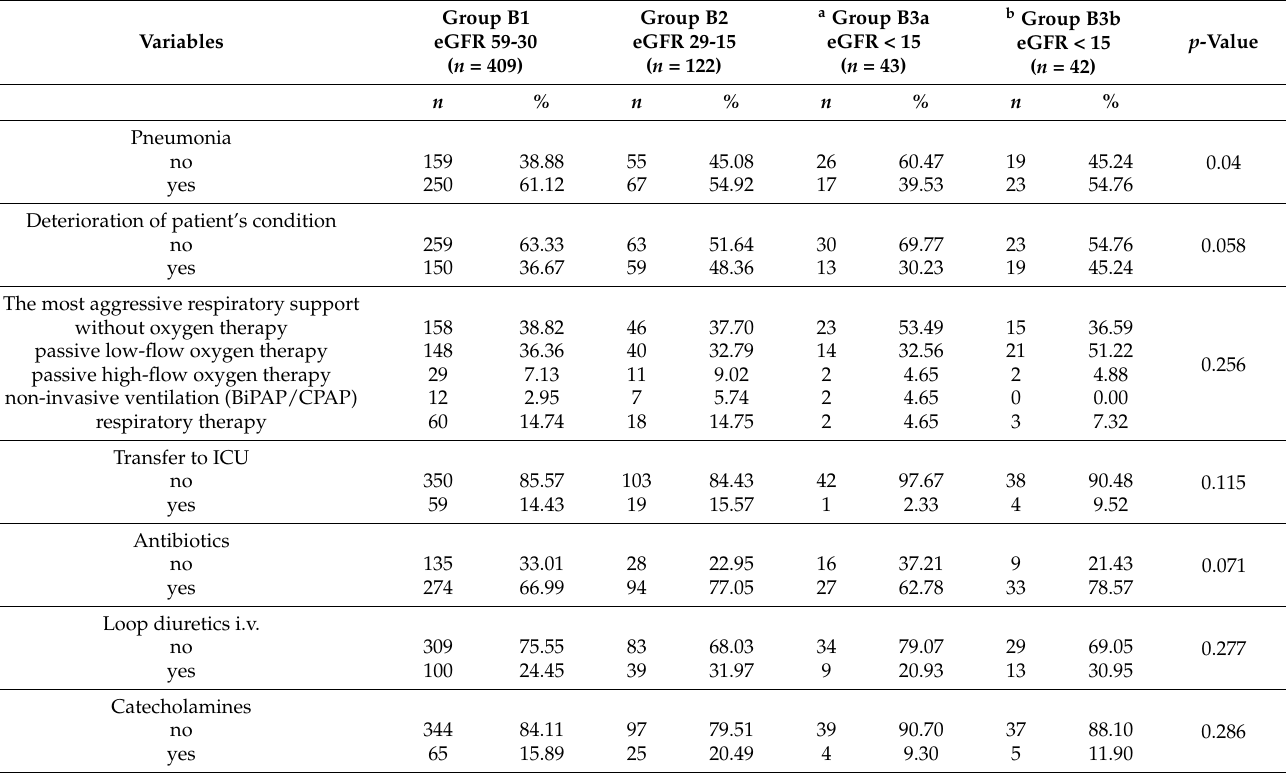
Table 6. Comparison of clinical parameters during hospitalization between subgroups of group B depending on eGFR value. Variables